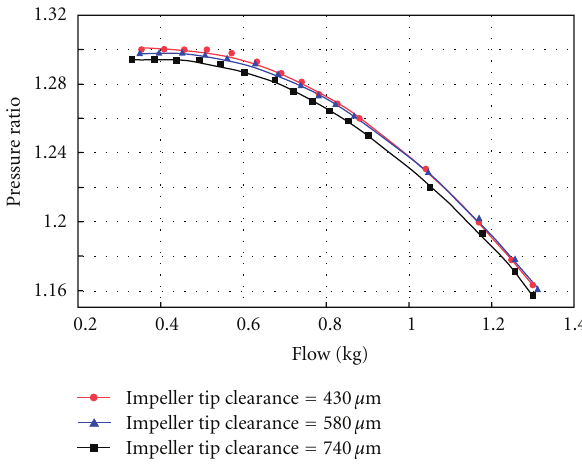
Figure 18: Impeller tip clearance modulation at 14,900